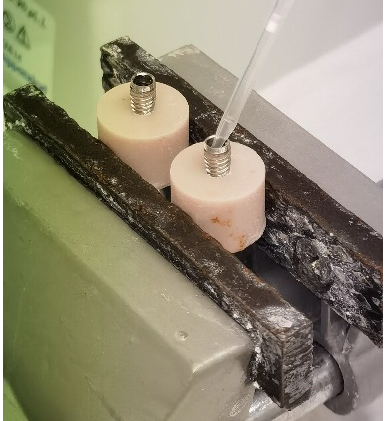
Figure 6. Inoculation of implant’s inside with 1.0 µL of viable bacterial. The quantity of bacterial broth, to inoculate inside the implant platform, was previ- ously evaluated with a preliminary test.